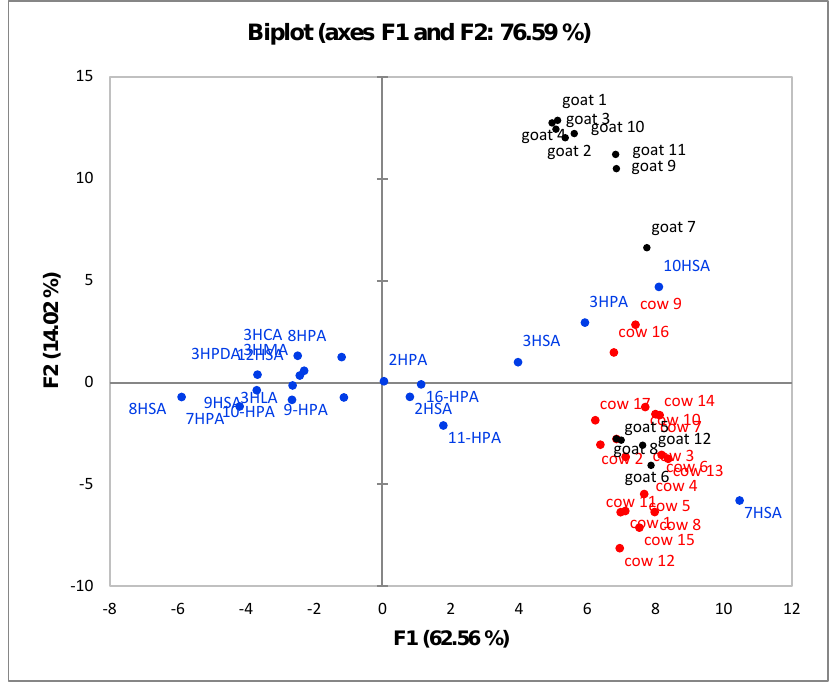
Figure 3. Principal component analysis (PCA) biplot graph of HFAs from cow and goat milk. Active variables (cow red, goat black), active observations (blue).